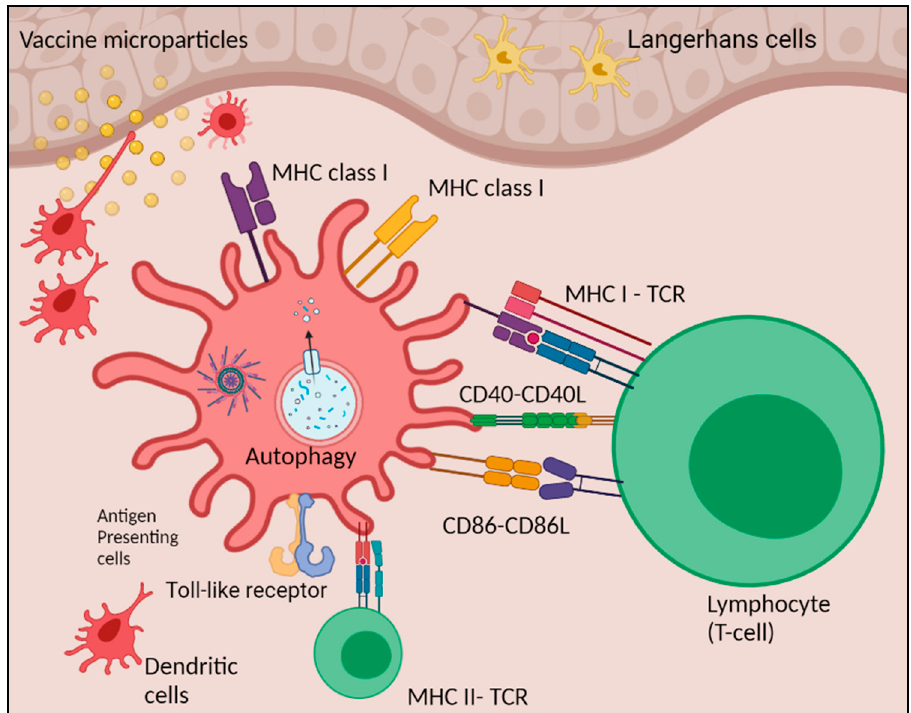
Figure 7. Schematic presentation of immune cells activation post vaccine MP uptake. Adjuvanted gonococci microparticles (Gc-MP+ Alum MP+ AddaVax™ MP) are effectively taken up by the antigen presenting cells (APCs), processed in the cytoplasm of the APCs, induced autophagosomes, and presented to the antigen presenting molecules (MHC I and II) with the help of co-stimulatory molecules (CD86 and CD40).